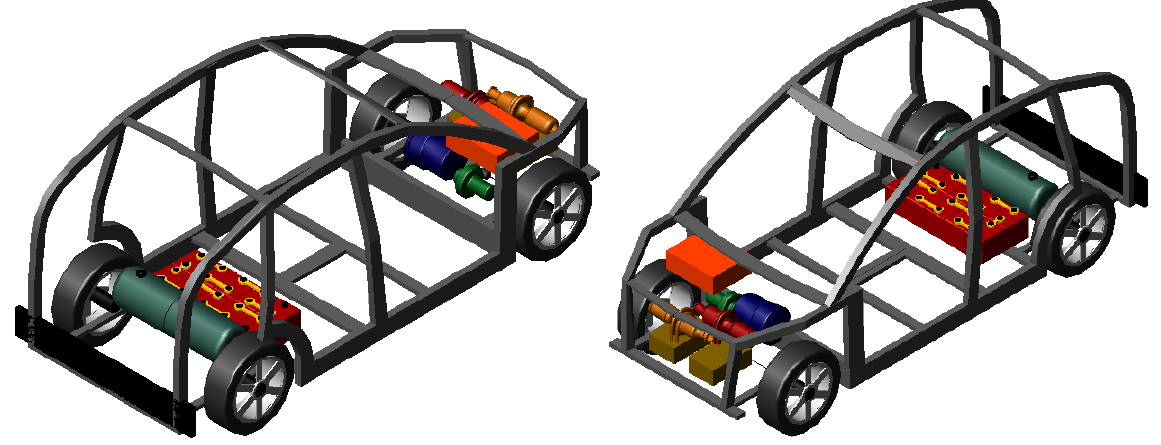
Figure 11. Components distribution for the LETHE © Sedan configuration.